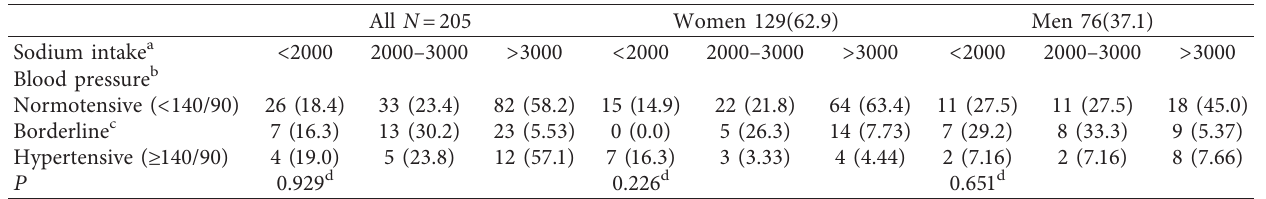
Table 2: Distribution of frequency and percentage of patient blood pressure based on sex sodium